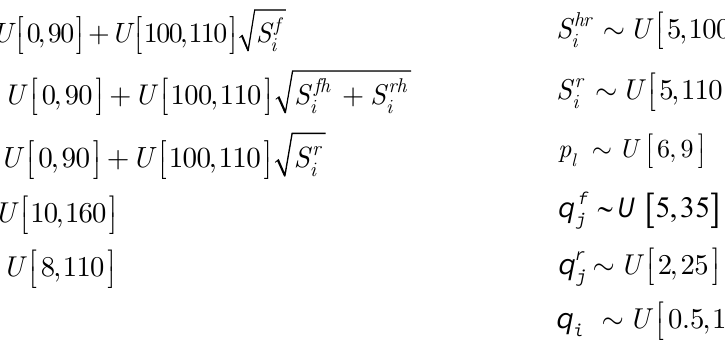
The summary of the proposed study for various centers and customers